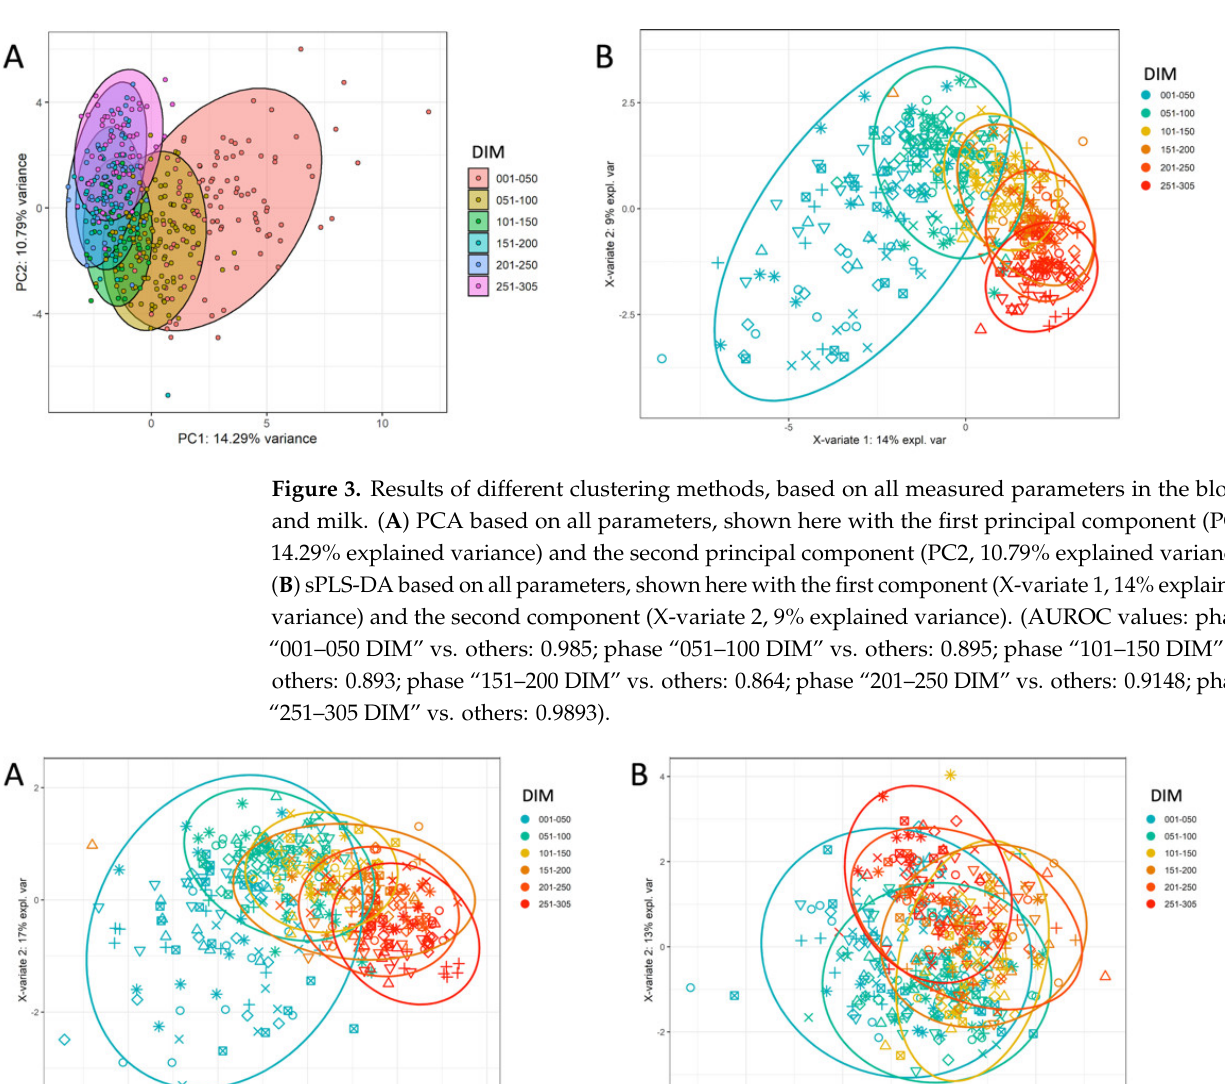
Figure 4. Results of sPLS-DA, based on different sets of parameters. ( A ) sPLS-DA based on milk HRDCC parameters, shown here with the first component (X-variate 1, 23% explained variance) and the second component (X-variate 2, 17% explained variance). (AUROC: phase “001–050 DIM” vs. others: 0.964; phase “051–100 DIM” vs. others: 0.83; phase “101–150 DIM” vs. others: 0.792; phase “151–200 DIM” vs. others: 0.732; phase “201–250 DIM” vs. others: 0.863; phase “251–305 DIM” vs. others: 0.965.) ( B ) sPLS-DA based on blood HRDCC parameters, shown here with the first component (X-variate 1, 16% explained variance) and the second component (X-variate 2, 13% explained variance). (AUROC: phase “001–050 DIM” vs. others: 0.831; phase “051–100 DIM” vs. others: 0.784; phase “101–150 DIM” vs. others: 0.794; phase “151–200 DIM” vs. others: 0.778; phase “201–250 DIM” vs. others: 0.792; phase “251–305 DIM” vs. others: